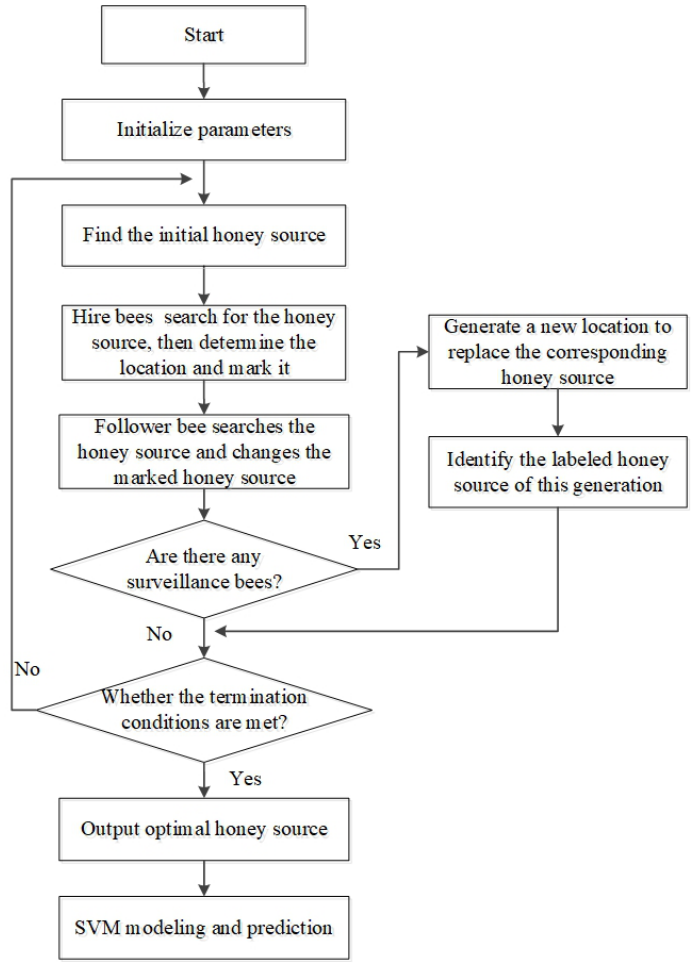
Fig. 1. Optimization of SVM modeling process based on ABC algorithm